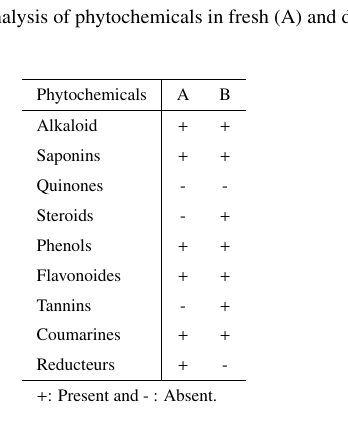
Values are mean of three replications (p ≤ 0.05; LSD test).